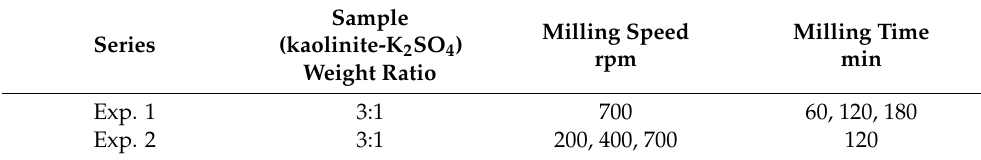
Table 1. Mixture ratios and conditions used in the